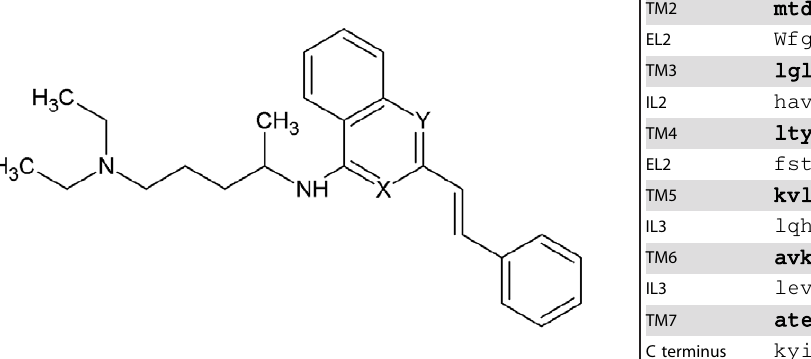
Figure 2. Structure of the quinazoline, quinoline and isoquin- oline derivatives where either X or Y or both equal N.